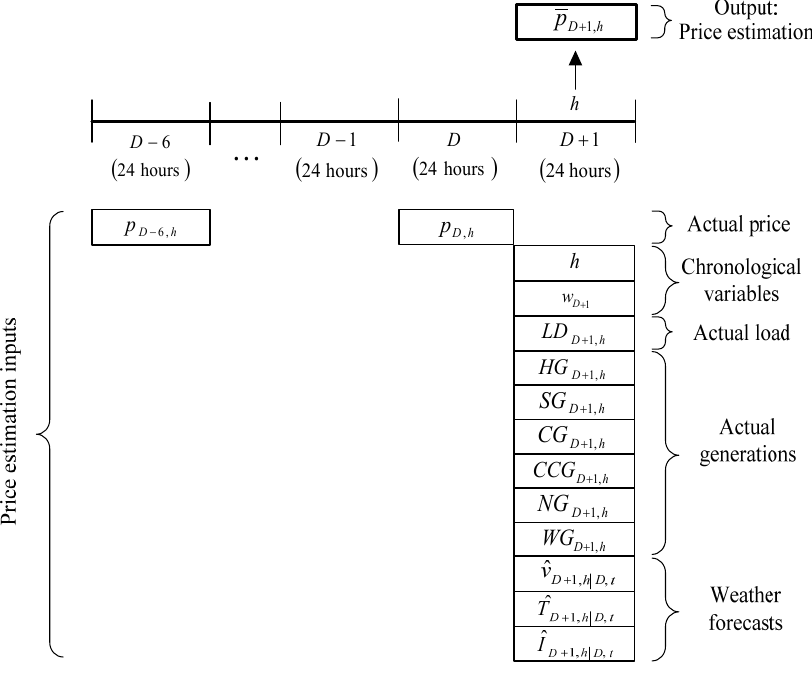
Figure 2. Time framework for price estimation of the REMPE